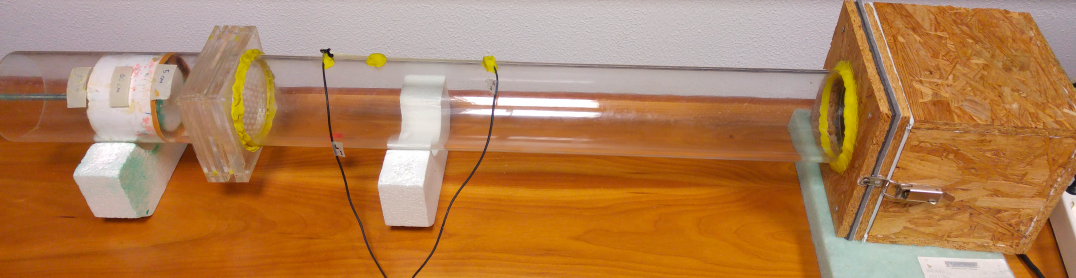
Figure 4. The 10 cm standing wave tube used to measure sound absorption coefficients in the frequency range from 100 Hz to 1.6 kHz. One of the triple layer samples is mounted in place.